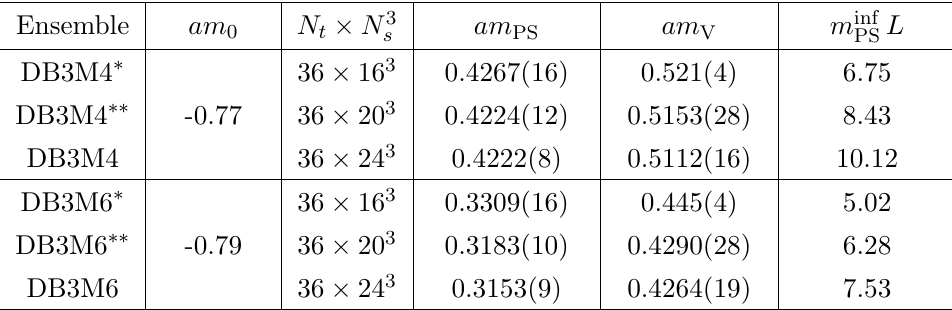
Table 4. Ensembles and numerical results used to estimate the size of (cid:12)nite volume e(cid:11)ects. The number of con(cid:12)gurations and the separation of trajectories between adjacent con(cid:12)gurations are given by N con(cid:12)gs = 200 and (cid:14) traj = 12, respectively, for all these ensembles. The pseudoscalar masses in the in(cid:12)nite volume limit m inf are estimated from the exponential (cid:12)ts as discussed in the PS